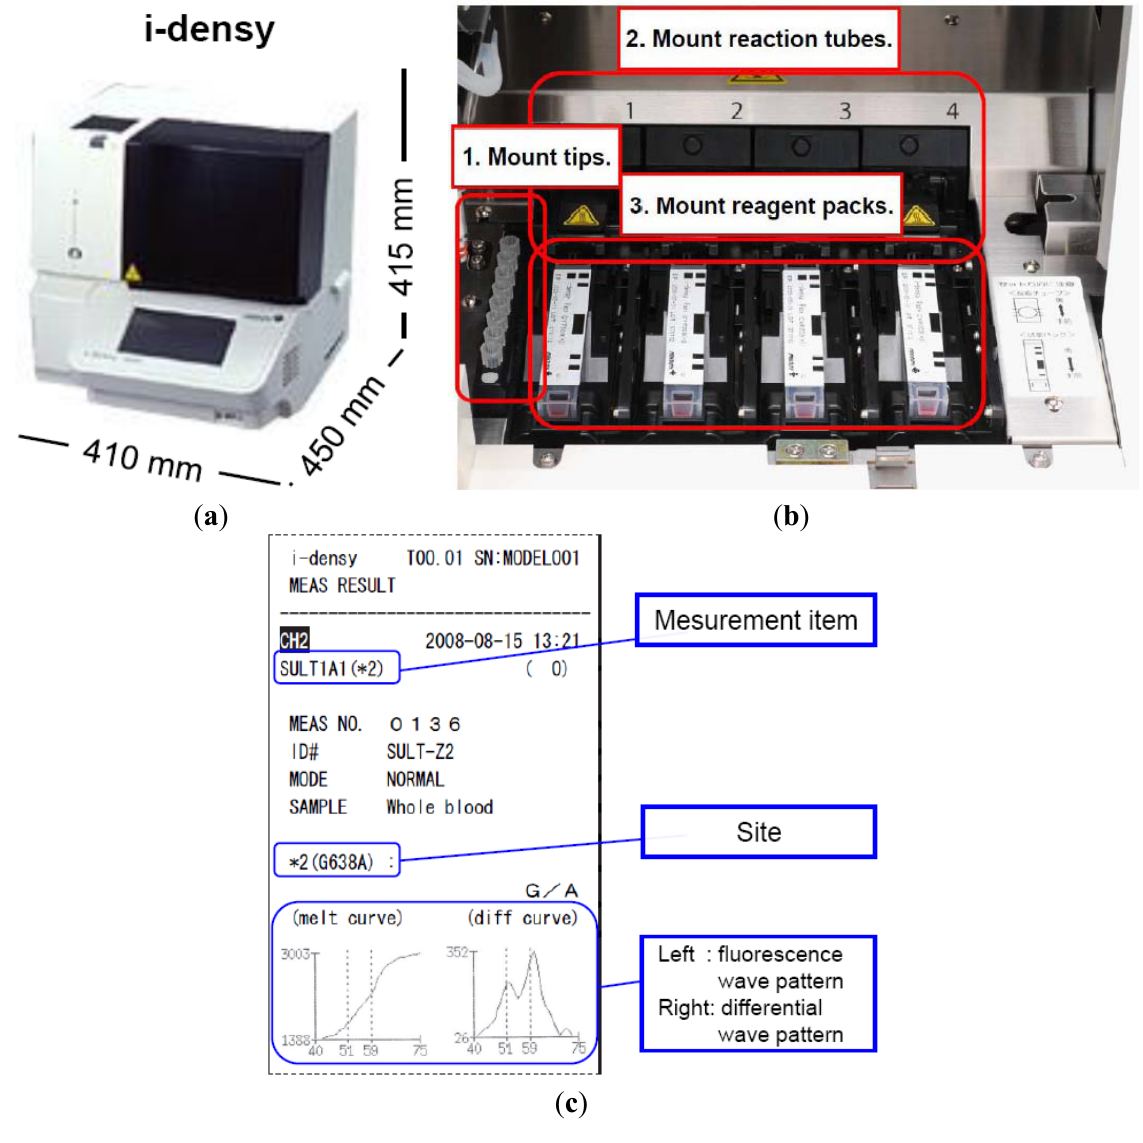
Figure 4. i-densy TM —Fully integrated and automatic gene typing system. ( a ) i-densy TM has a compact design: 410 mm (width) by 450 mm (depth) by 415 mm (height). ( b ) Before measurement, the necessary number of tips, reaction tubes, and reagent packs are put in place. The instrument contains 4 independently programmable reaction sites. ( c ) When measurement is complete, measurement results are automatically printed